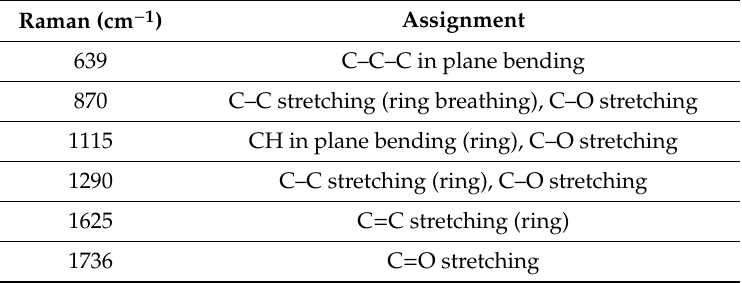
Figure 4 . ( a ) Optical density spectra of Ag nanoislands on donor PET and glass substrates and of their corresponding deposits on acceptor glass slides; ( b , c ) Normalized field distributions around 200-nm sized Ag NPs, supported on PET and glass substrates, in the field of the 1064-nm plane wave. Right-hand color scales show the field enhancement magnitude. Table 1. PET Raman bands and their assignment .